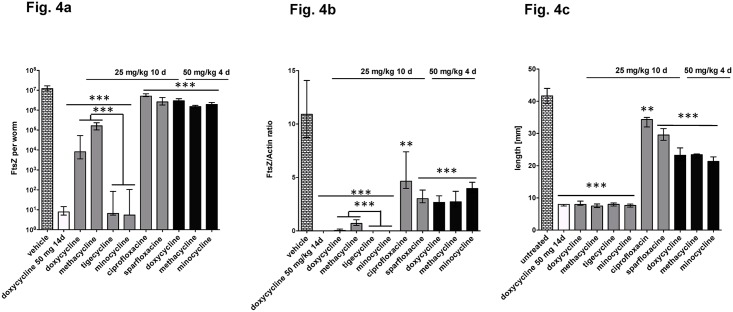
Comparison of different antibiotics for Wolbachia depletion.Antibiotics were administered intraperitoneally at 25mg/kg/d for 10 days or 50mg/kg/d for 4 days. Worms were recovered at day 35 post infection. (a) FtsZ copy numbers and (b) FtsZ/Actin ratio are given per single female worm. The female worm length is shown in (c). Significances were tested with Mann-Whitney-U test. *p<0.05; **p<0.01; ***p<0.001. Exact p-values are given in S1 Table.